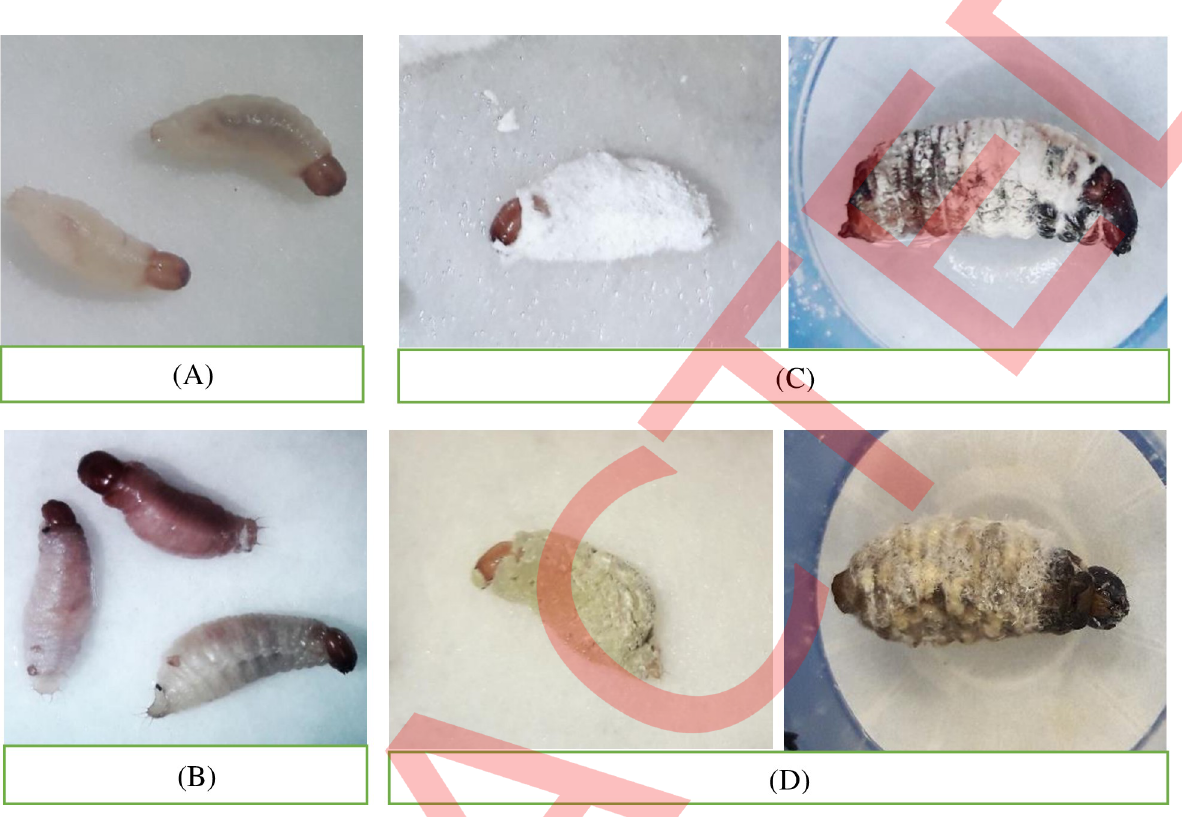
Fig 2. Comparison of healthy and fungi treated red palm weevil larvae. Healthy larvae, (3 and 35 days old) exposed to distilled water (control) (A), early symptoms of infection (1 day after dead) by fungi (B), and infected larvae (3 and 35 days old), exposed to fungi Beauveria bassiana (C) and Metarhizium anisopliae (D) (treated) (1 × 10 9 conidia/ml) under laboratory condition.